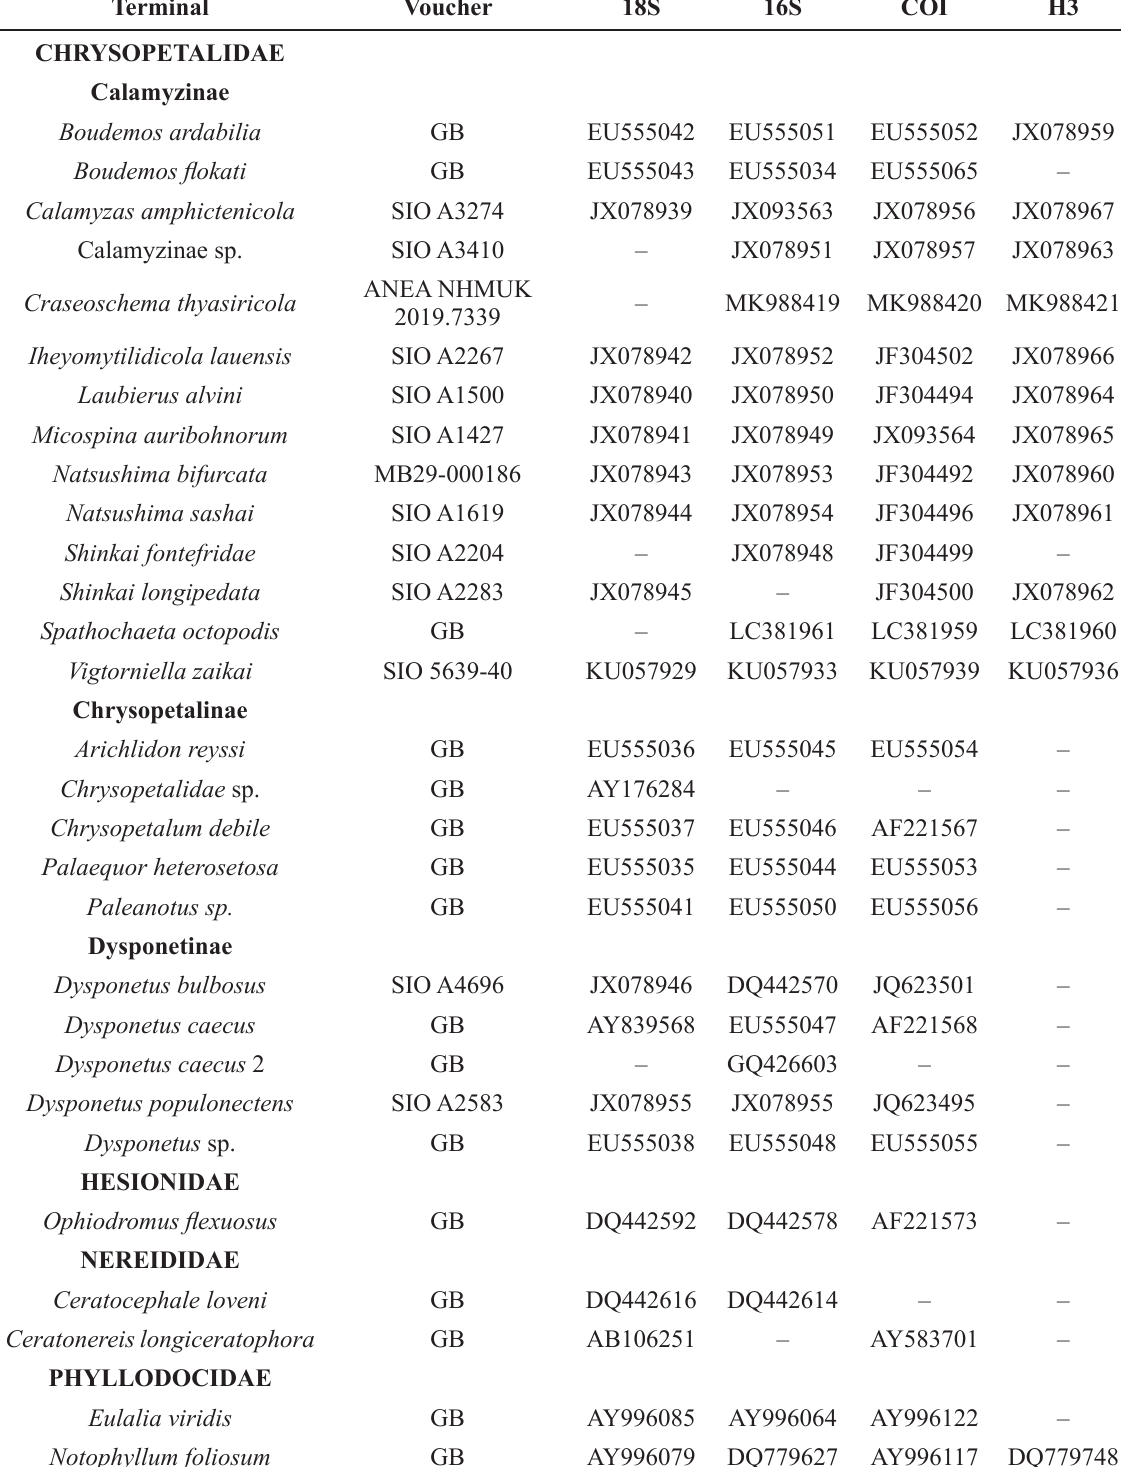
Table 2 . Sequenced specimens and GenBank accession numbers. GB = sequences obtained from NCBI GenBank; SIO = Scripps Institution of Oceanography; MB = Museu Nacional de História Natural de Lisboa (Museu Bocage); DBUA = Research Collection of Marine Invertebrates, Dep. Biologia, Universidade de Aveiro; ANEA NHMUK = Natural History Museum, London, UK; – = missing